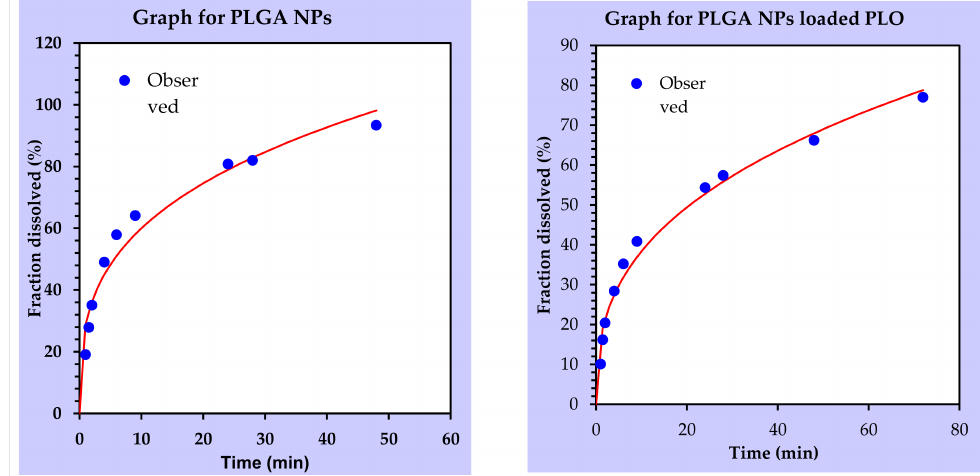
Figure 8. Best fitness graphs of the Korsmeyer–Peppas model of PLGA NPs and NP-loaded PLO obtained with a DD